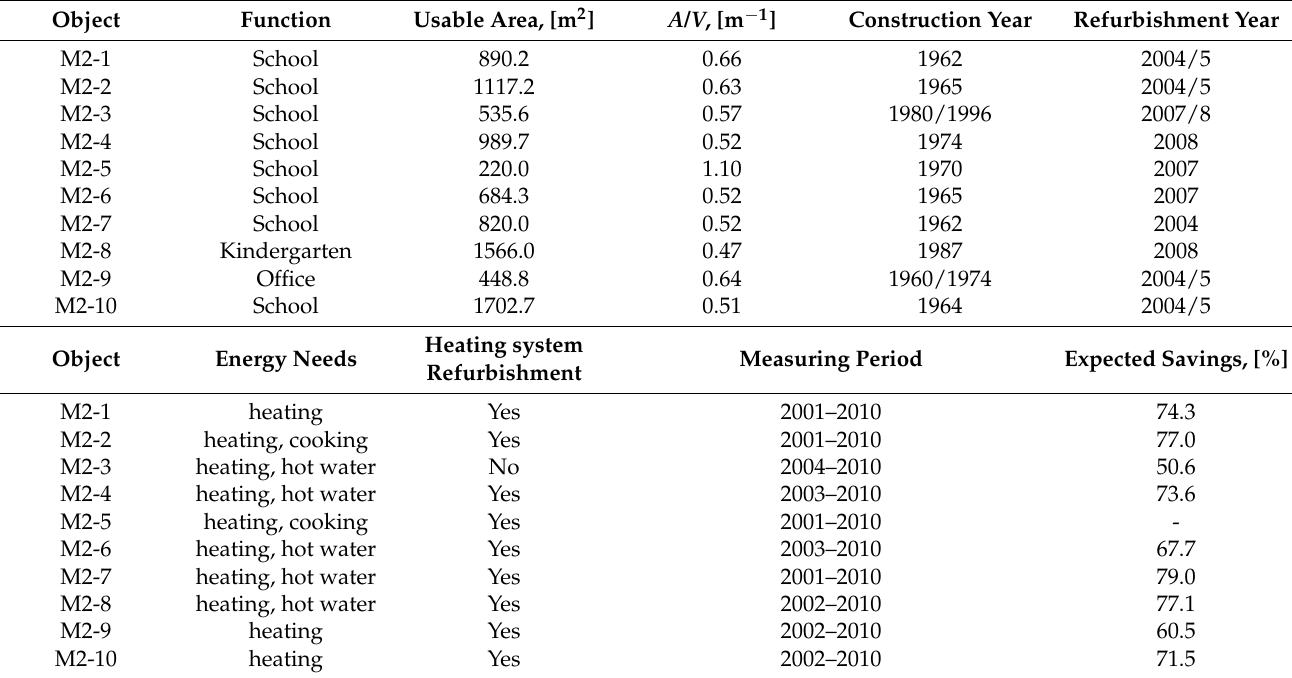
Table 3. Characteristic of buildings from group M2.